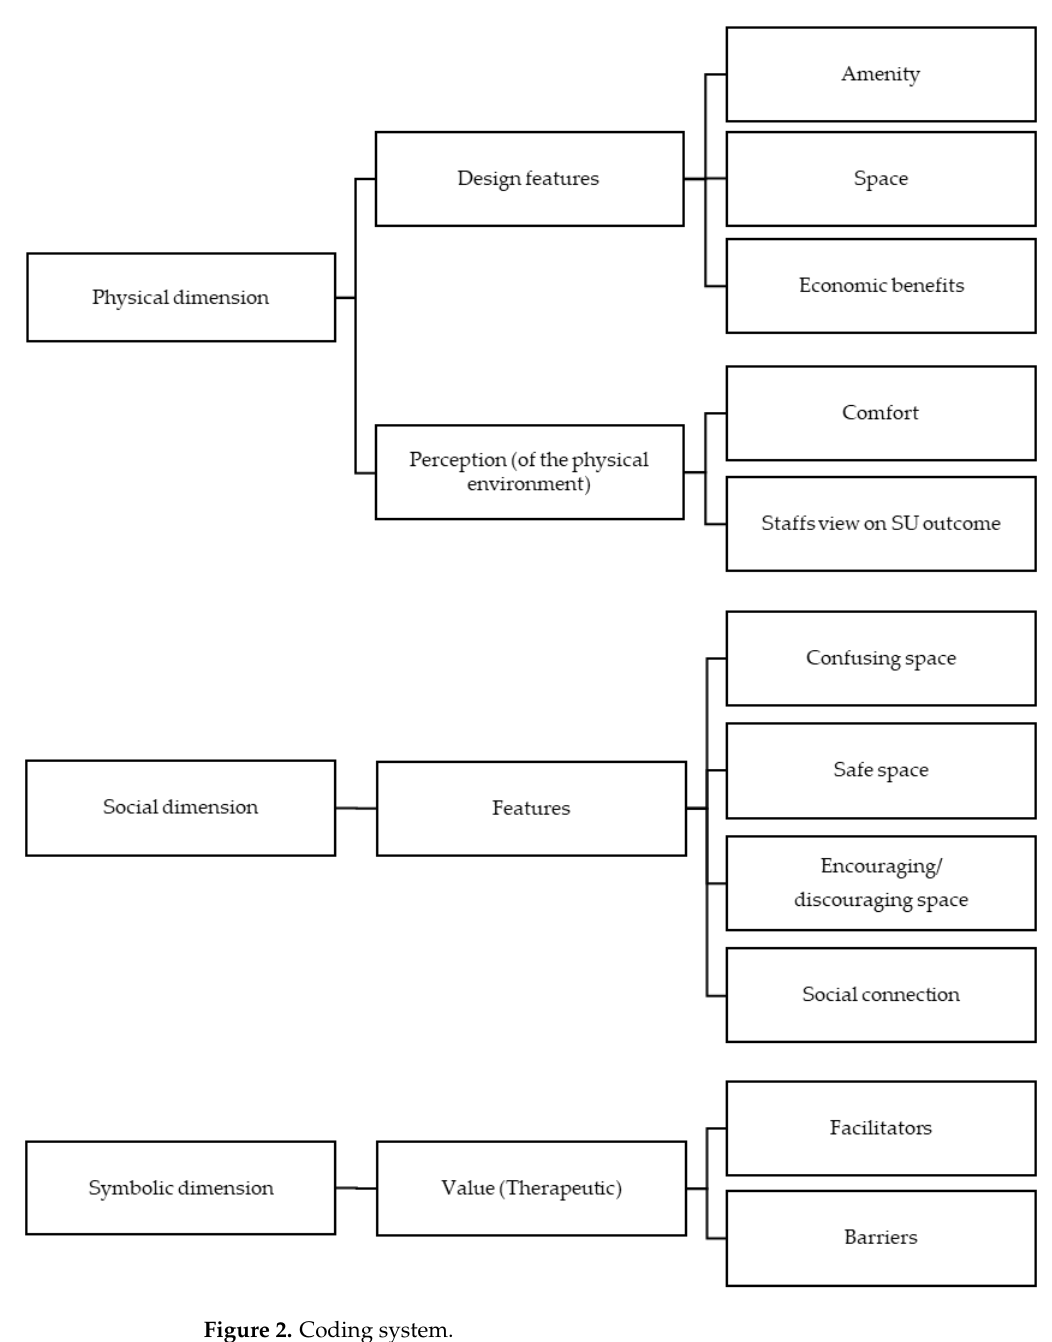
Figure 2. Coding